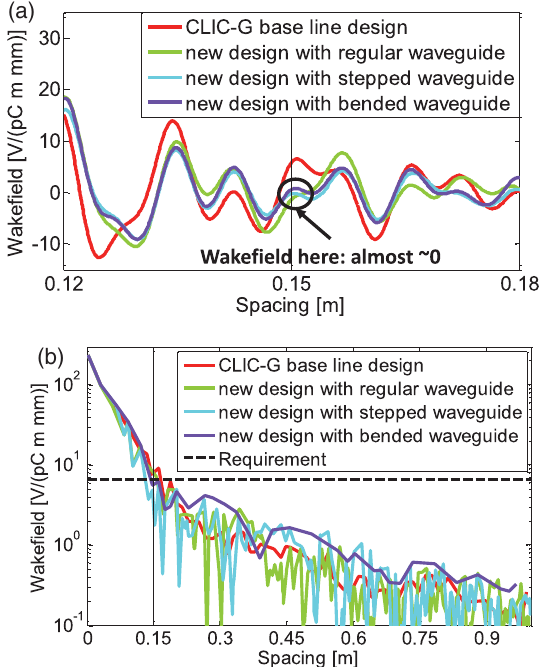
FIG. 22. Wakefield of all designs in two difference scales: (a) wakefield at the nearby position of the second bunch; (b) log- scale enveloped wakefield plot from 0 to 1 meter.